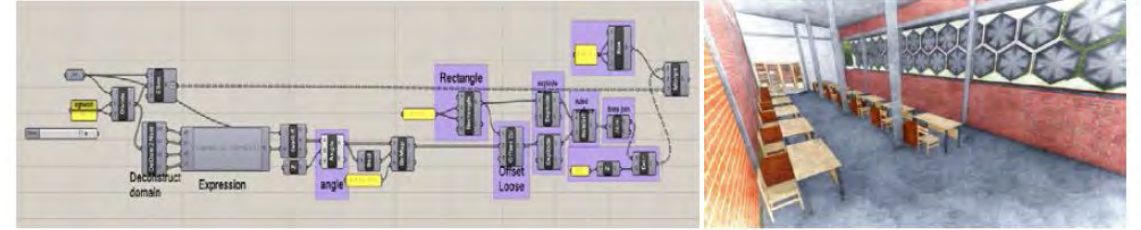
Figure 4. Parametric Wall